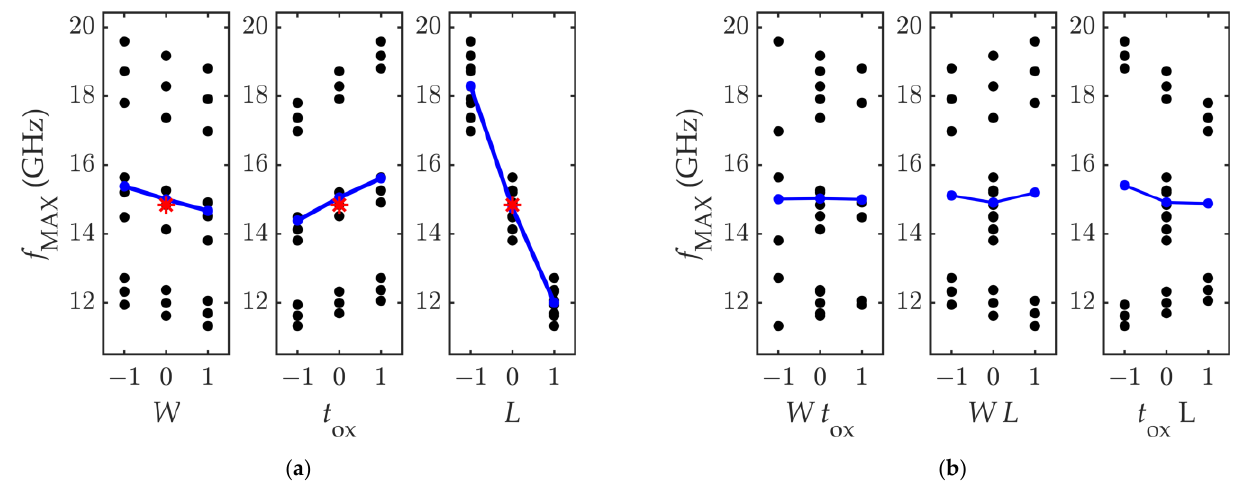
Figure 6. Computed values of f MAX against ( a ) the input factors and ( b ) the factor-mixed products. The blue lines connect the f MAX average values, and the red star marks the response computed at the nominal set of the input parameters.